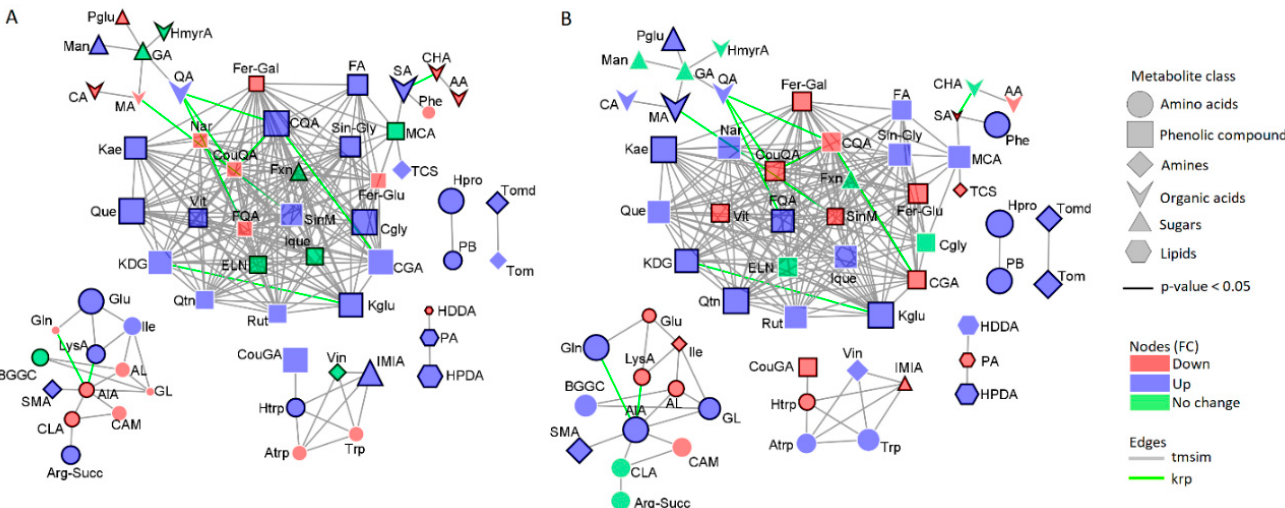
Figure 4. Metabolic networks displaying interconnections between chemically related metabolites in tomato plants and their relative responses to salt stress ( A ) and biostimulant treatment ( B ). The downregulation, upregulation, and no change in metabolites under different treatments are represented by red, blue and green nodes, respectively. The black borderline on the nodes indicates statistical significance ( p -value < 0.05). Metabolite classes are represented as node shapes, as per key indicated. Interconnections between metabolites are represented by grey and green edges for chemical (tmsim) and KEGG reaction pair (krp), respectively.